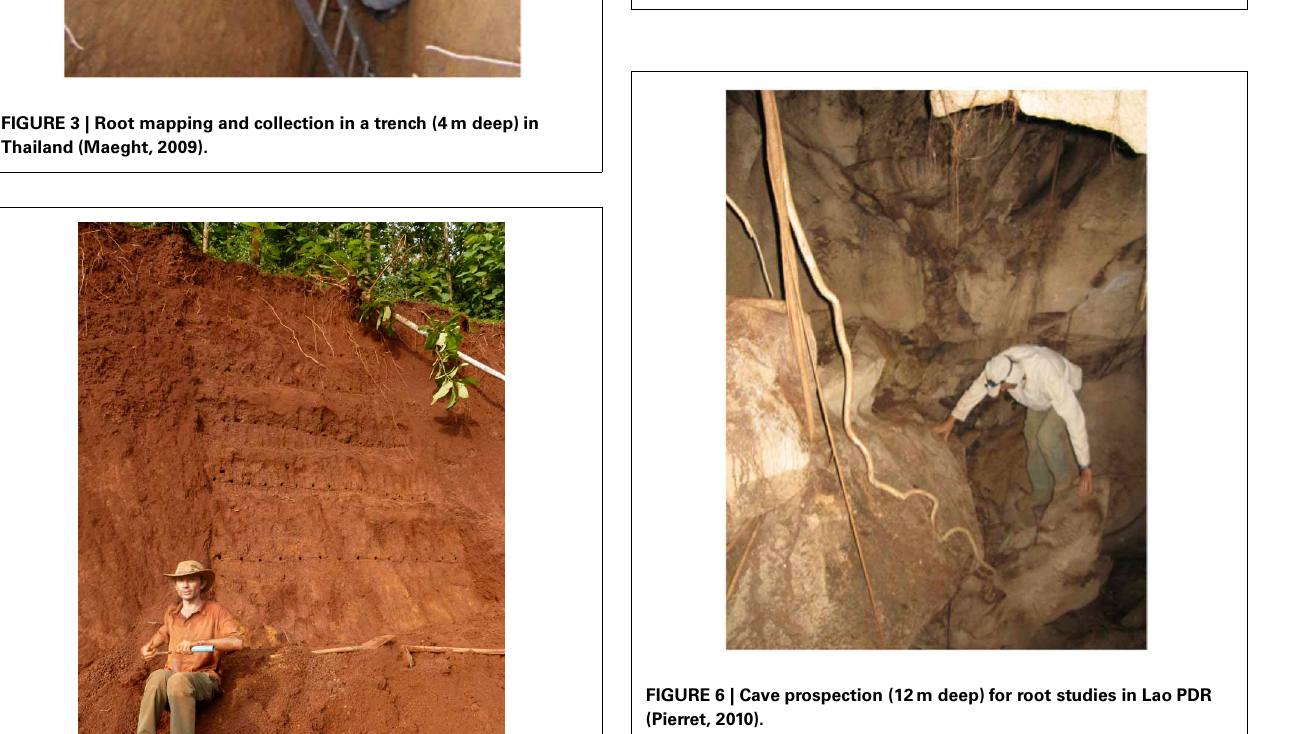
approaches, (ii) MRs, (iii) access shafts, and (iv) caves and mines.